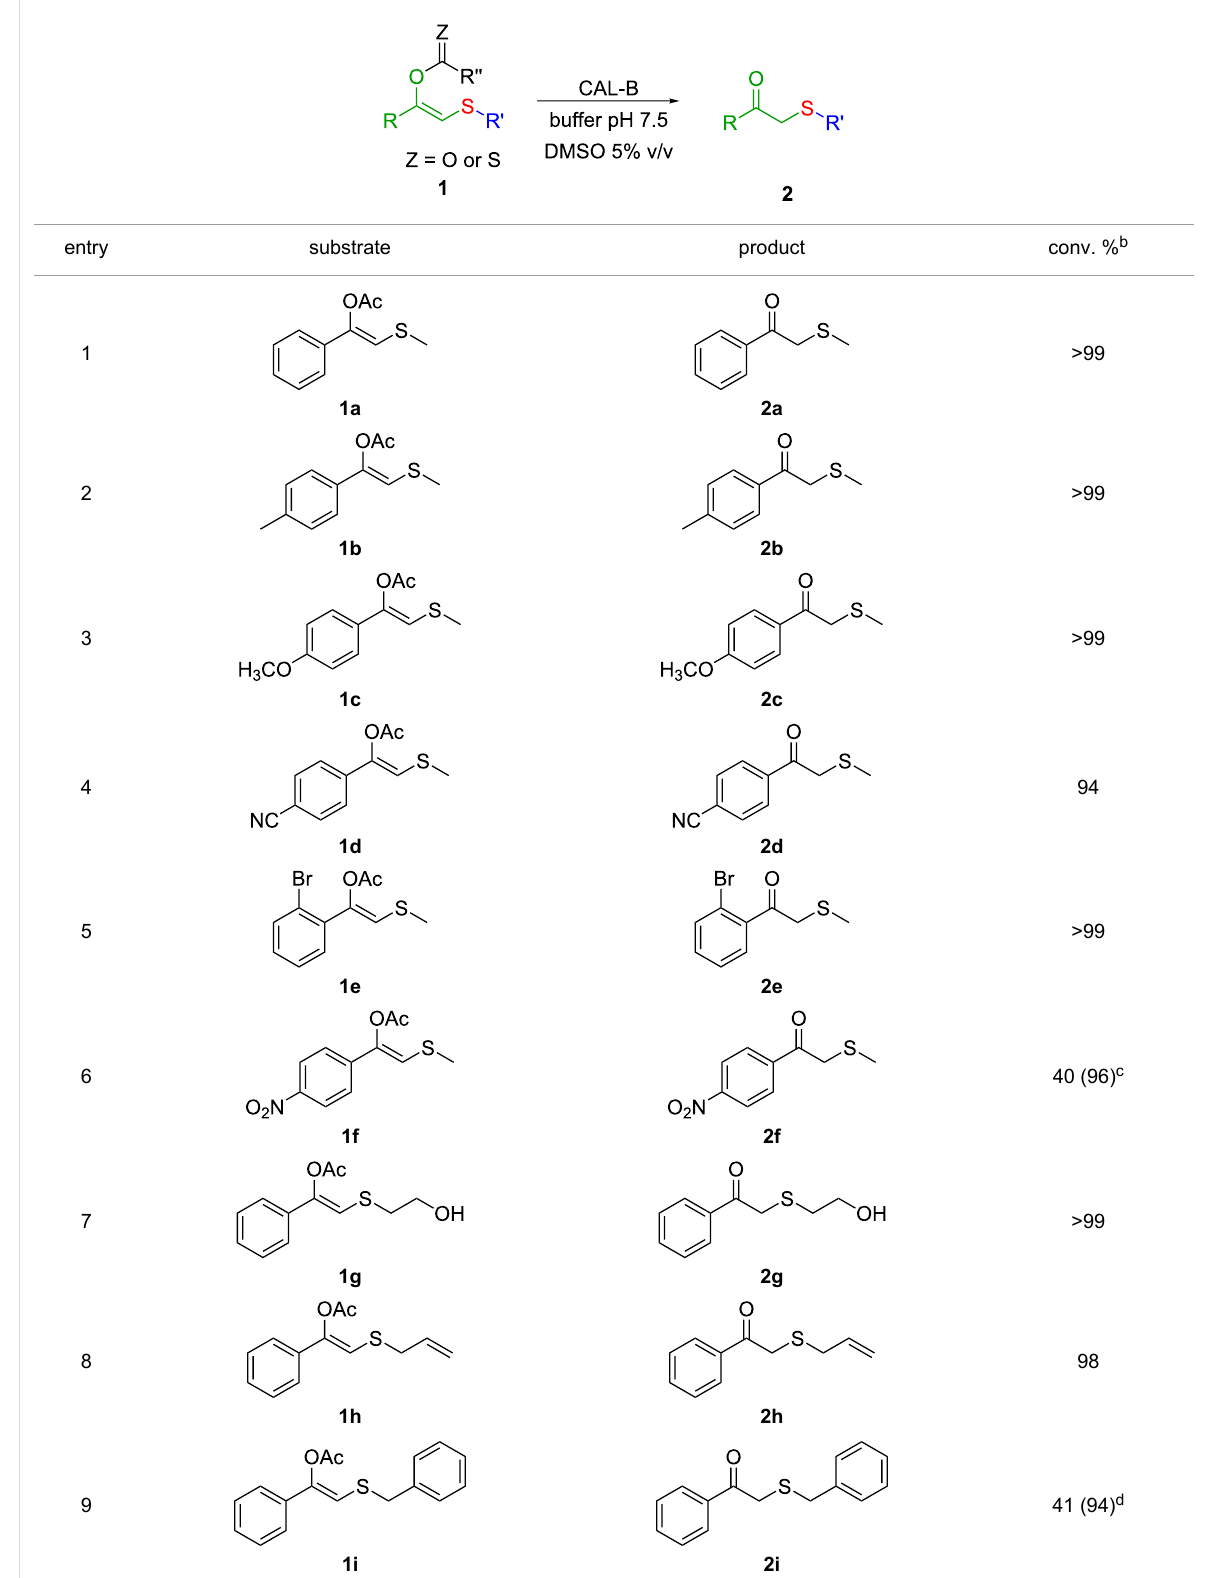
Table 2: Lipase-catalysed hydrolysis–protonation sequence over a series of β -thioalkyl enol esters.